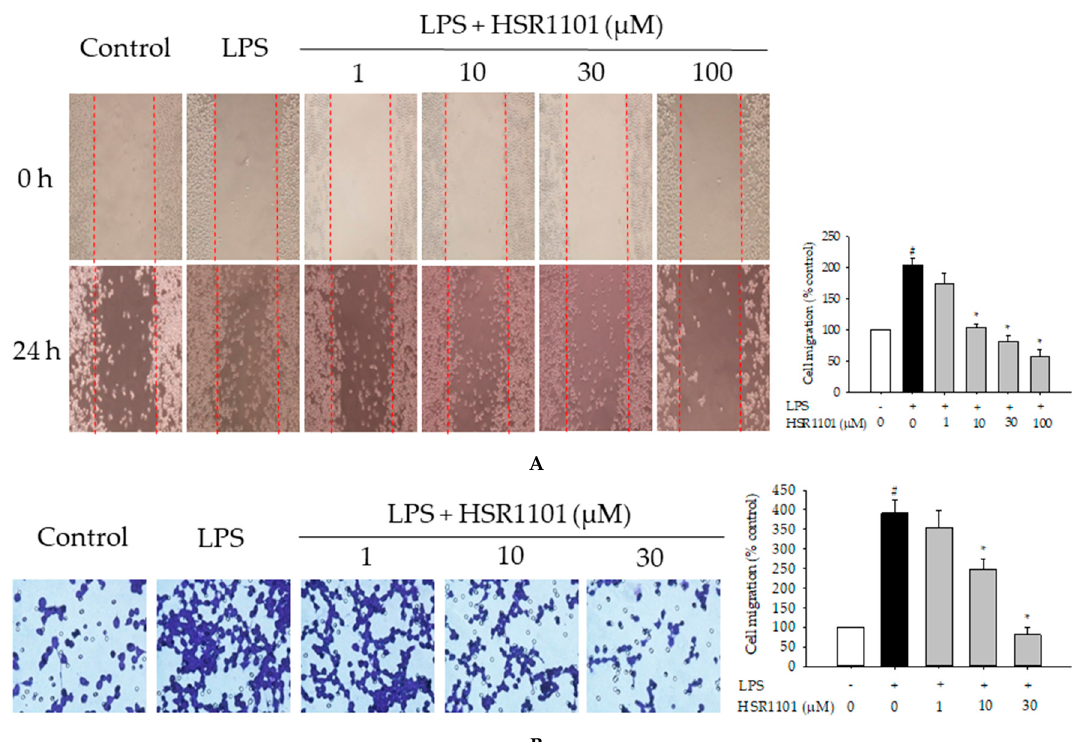
Figure 6. HSR1101 inhibited LPS-induced migration of BV2 cells. BV2 cells were co-treated with 1 µg/mL LPS and a series of concentrations of HSR1101 for 24 h and then analyzed for differences in migration of cells by wound healing ( A ) and transwell migration assays ( B ), as described in the Materials and Methods section. Data are expressed as mean ± SEM of at least three independent experiments. # p < 0.05 and * p < 0.05 vs the vehicle-treated control and LPS-treated groups, respectively. LPS, lipopolysaccharide.